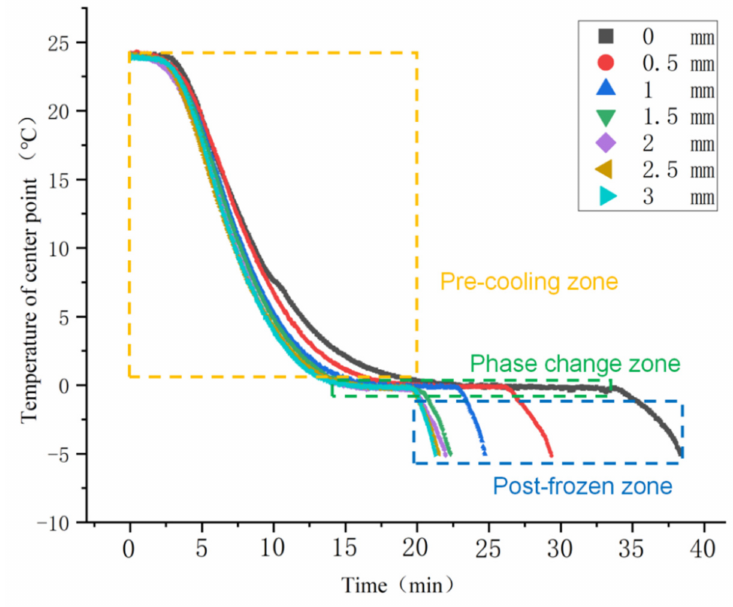
Figure 10. Relationship between center point temperature and time.